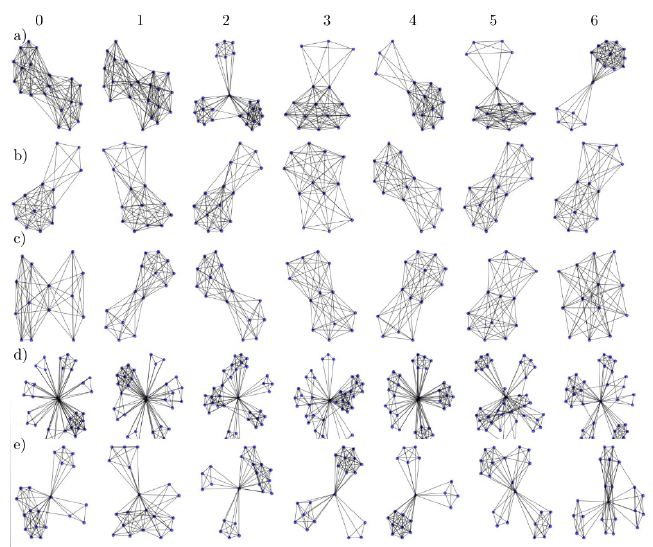
Figure A2. Six nearest neighbors of graphs in latent space from IMDB for ten graphs. Column 0 correspond to the randomly chosen graph then the six nearest neighbors are draw in increasing distance order from left to right (from 1 to 6).